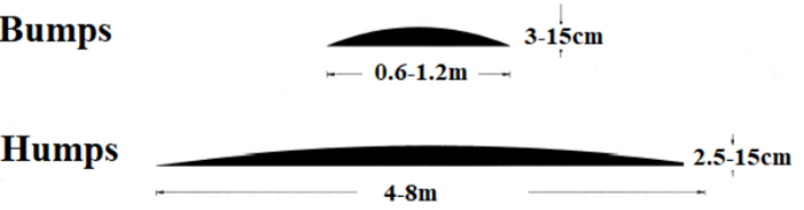
Figure 1. Without being exhaustive in the presentation calming control devices, the main differences between speed bumps/humps are sketched. See also Tables 1 and